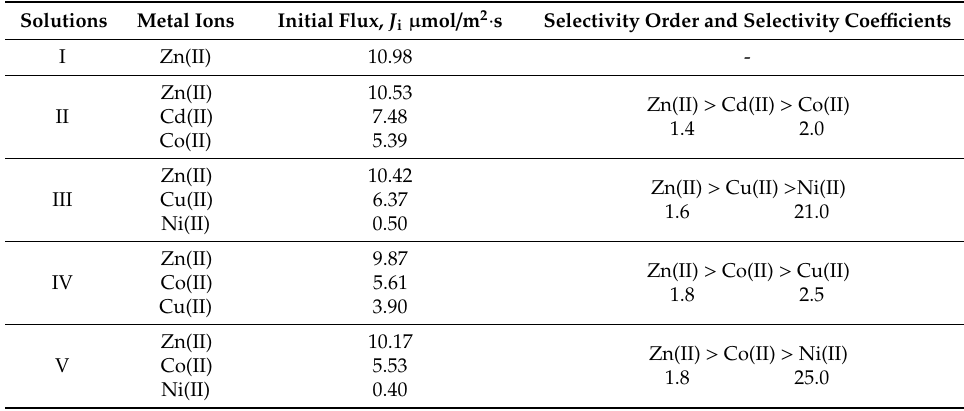
Table 3. Initial fluxes, order and separation coefficients for competitive transport of Co(II), Ni(II), Cu(II), Zn(II), and Cd(II) through membrane doped with EDAB-acac. Conditions as in Figures